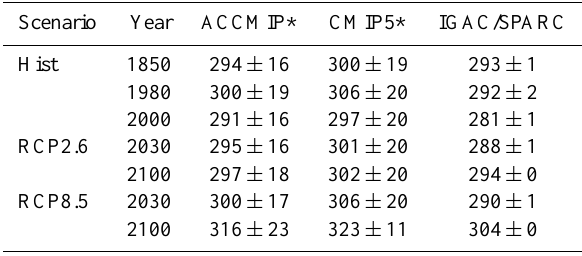
Table 2. Global annual mean of TCO (DU).